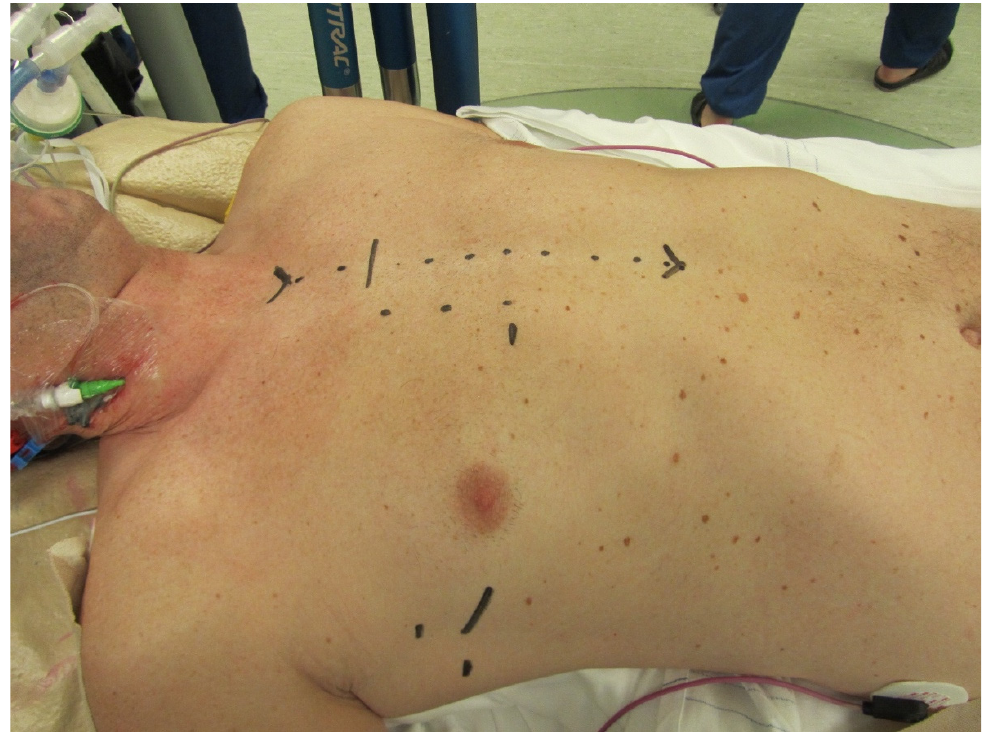
Figure 5. Marking of the incisions for MIMVS and the incision for conversion to